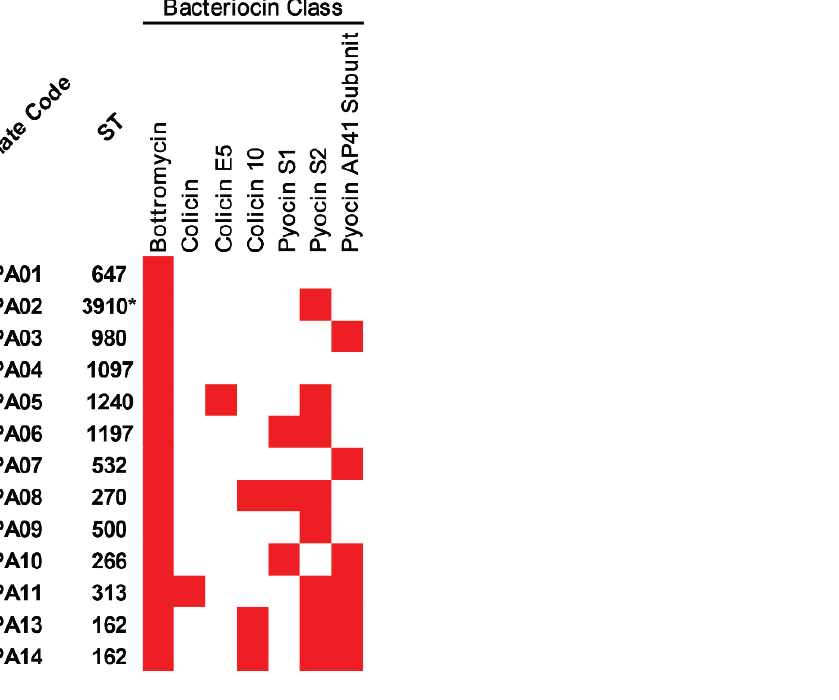
Figure 4. Bacteriocins in the colonizing isolates of P. aeruginosa . The red box represents the gene presence. * Novel ST. Table 3. Clustered regularly interspaced short palindromic repeats and CRISPR-associated protein (CRISPR-Cas) system in the colonizing isolates of P. aeruginosa